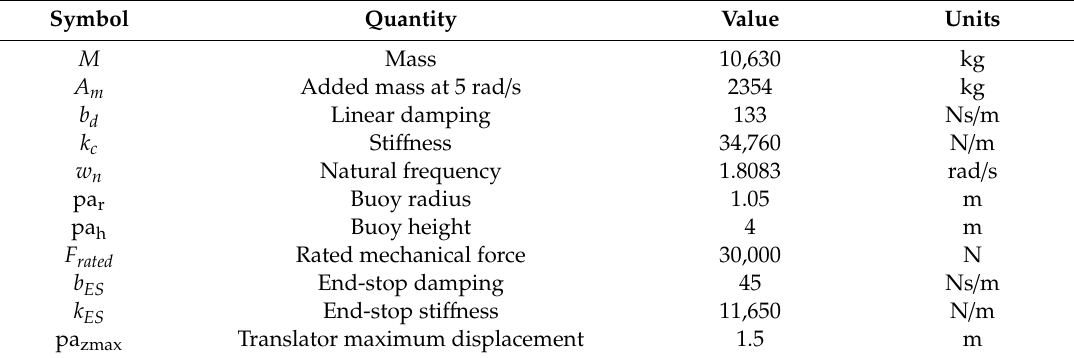
Table 1. Hydrodynamic and point absorber constant parameters for the cylindrical buoy under study.